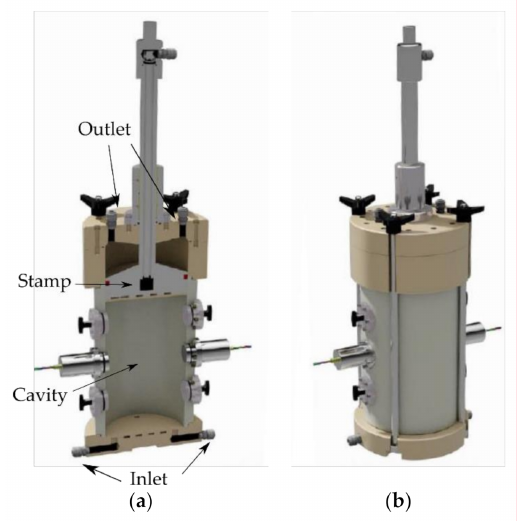
Figure 3. ( a ) Cross-section view of the prototype of the proctor mould without a load frame; ( b ) full assembly